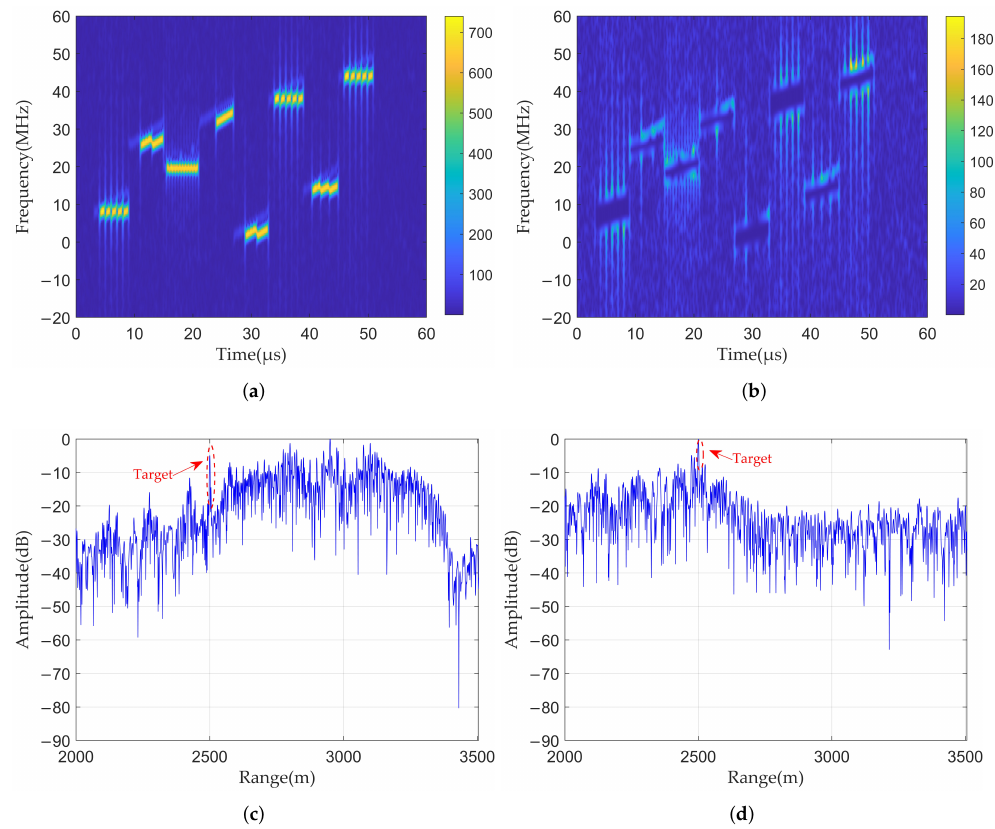
Figure 8. Suppression effect of Ref. [20] on NUISRJ: ( a ) time–frequency distribution before suppres- sion, ( b ) time–frequency distribution after suppression, ( c ) pulse compression before suppression, ( d ) pulse compression after